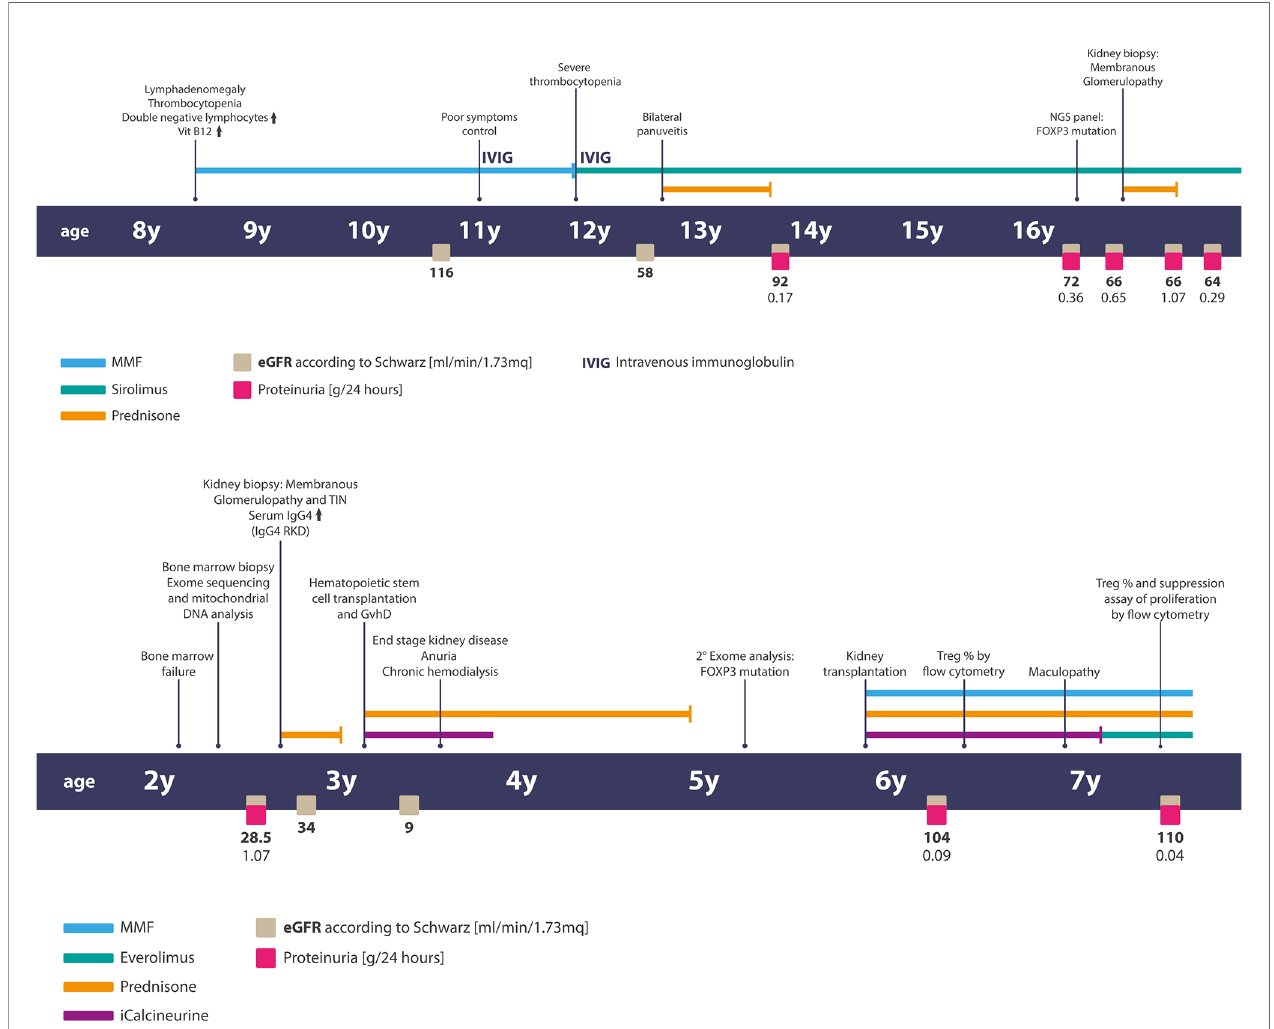
FIGURE 1 | Timelines of clinical events, diagnostic exams, and treatments of patients. Above — the timeline of patient 1 and below — the timeline of patient